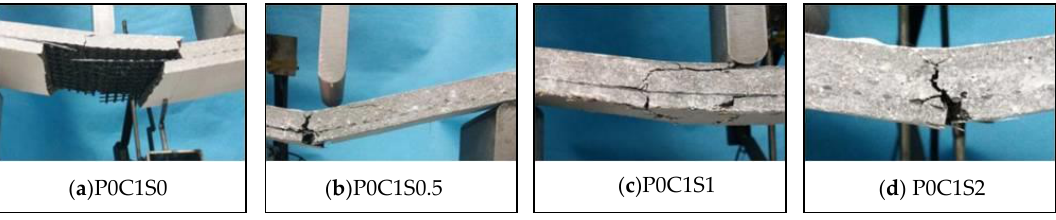
Figure 17. Failure modes of the TRC specimens with different volume contents of steel fibres.